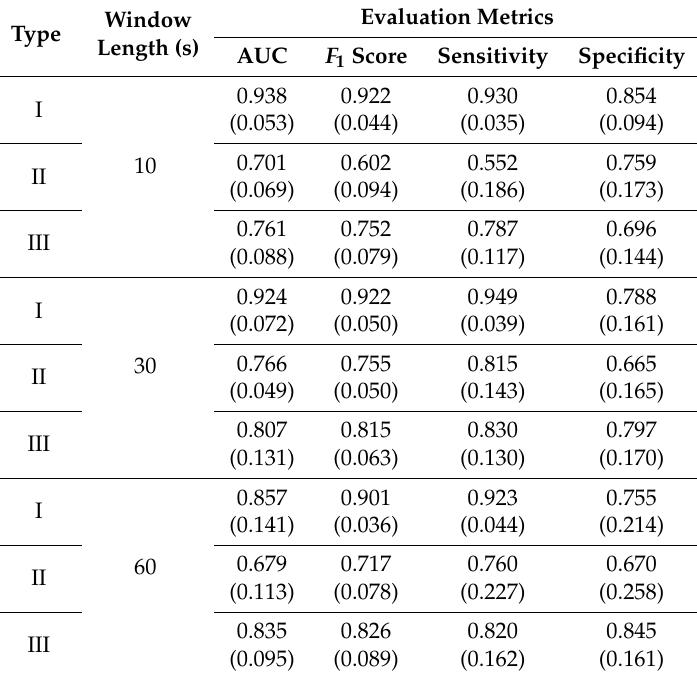
Table 6. Evaluation